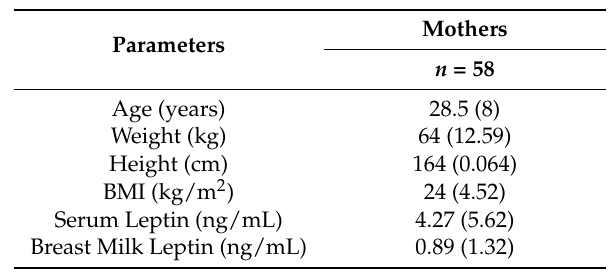
Table 2. Maternal anthropometric parameters, serum leptin and Breast Milk (BM) leptin values (median +